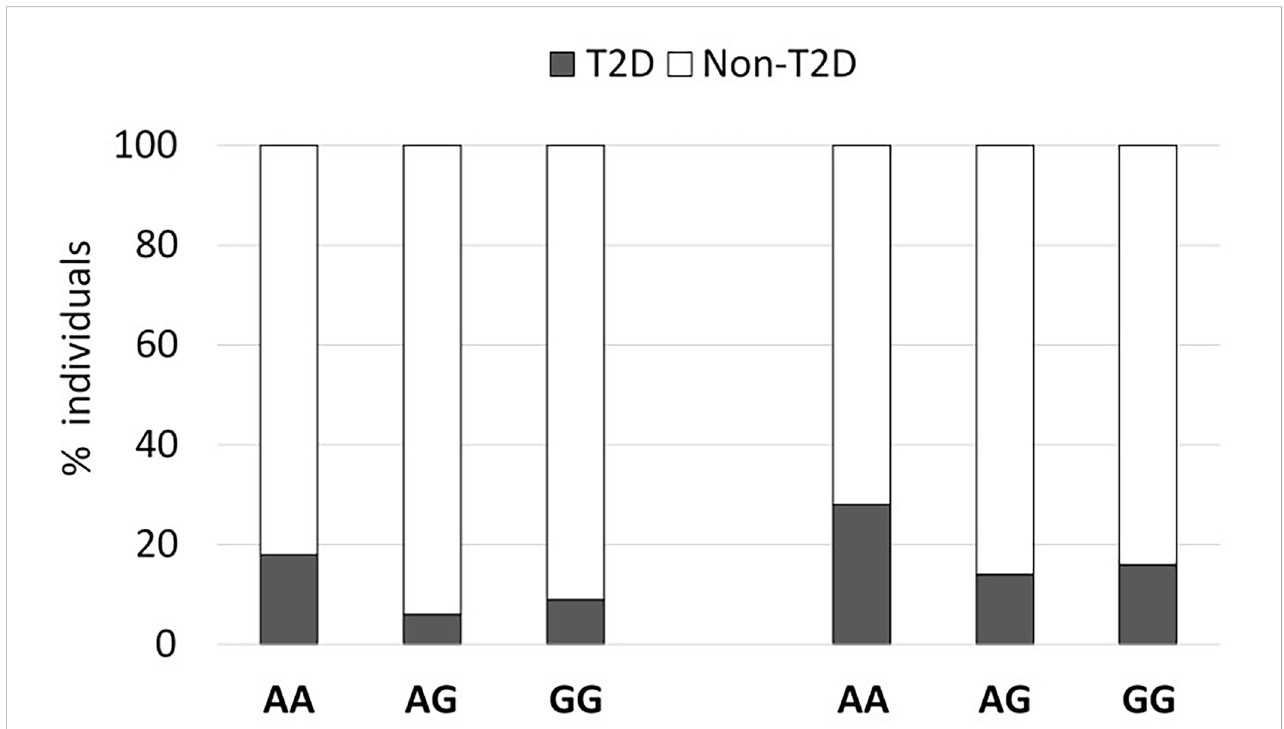
FIGURE 1 An exonic SNP in LncTGM2 is associated with T2D risk. The graph shows the percent of T2D in two independent cohorts segregated according to their rs2076380